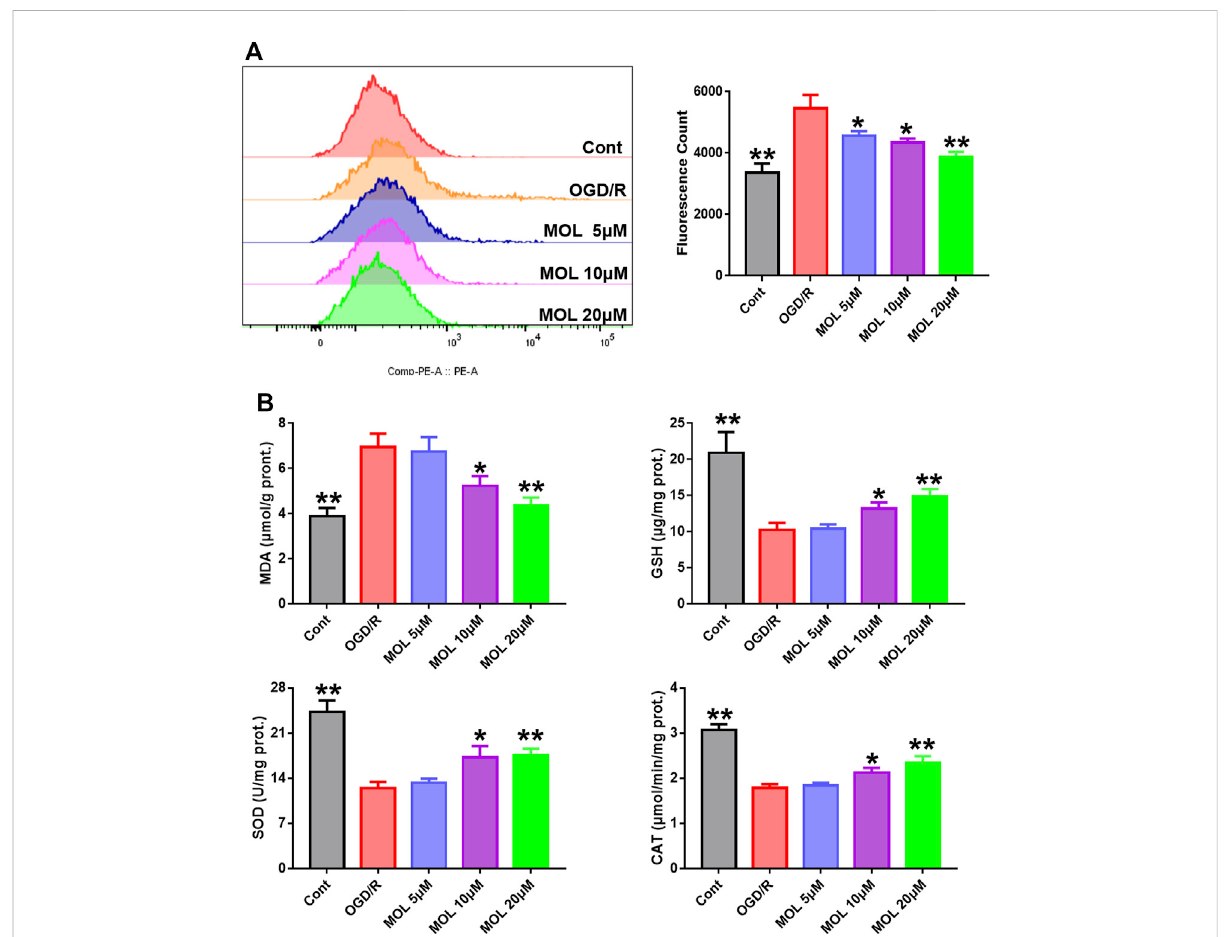
FIGURE 6 MOLintervention canimprove theoxidative stresslevel ofSHSY-5YcellstreatedwithOGD/R. (A) :MOL(5,10,20 μ M)inhibitedROSproduction in SHSY-5Y cells treated with OGD/R; (B) MOL (5, 10, 20 μ M) increased the levels of SOD, CAT and GSH in SHSY-5Y cells treated with OGD/R, and decreased the levels of MDA. Data expressed as Mean ± SD, ** p < 0.01, * p < 0.05 vs. OGD/R